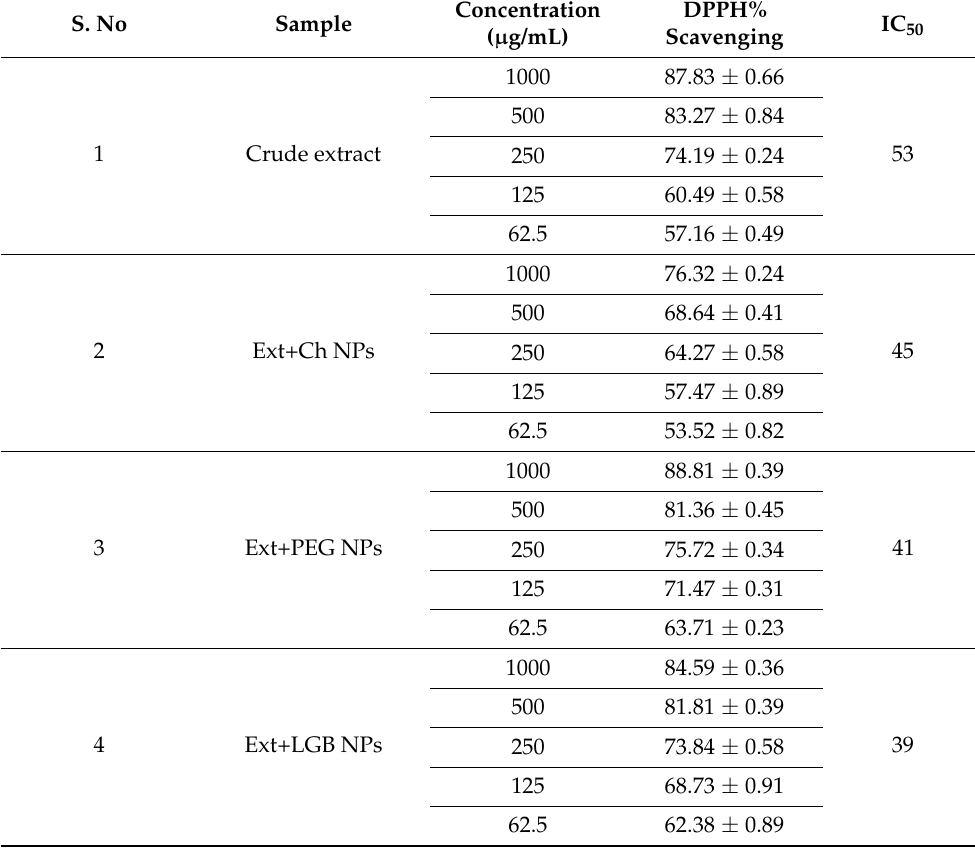
Table 5. Antioxidant potential of Indigofera linifolia crude extracts and prepared nanoparticles. S.